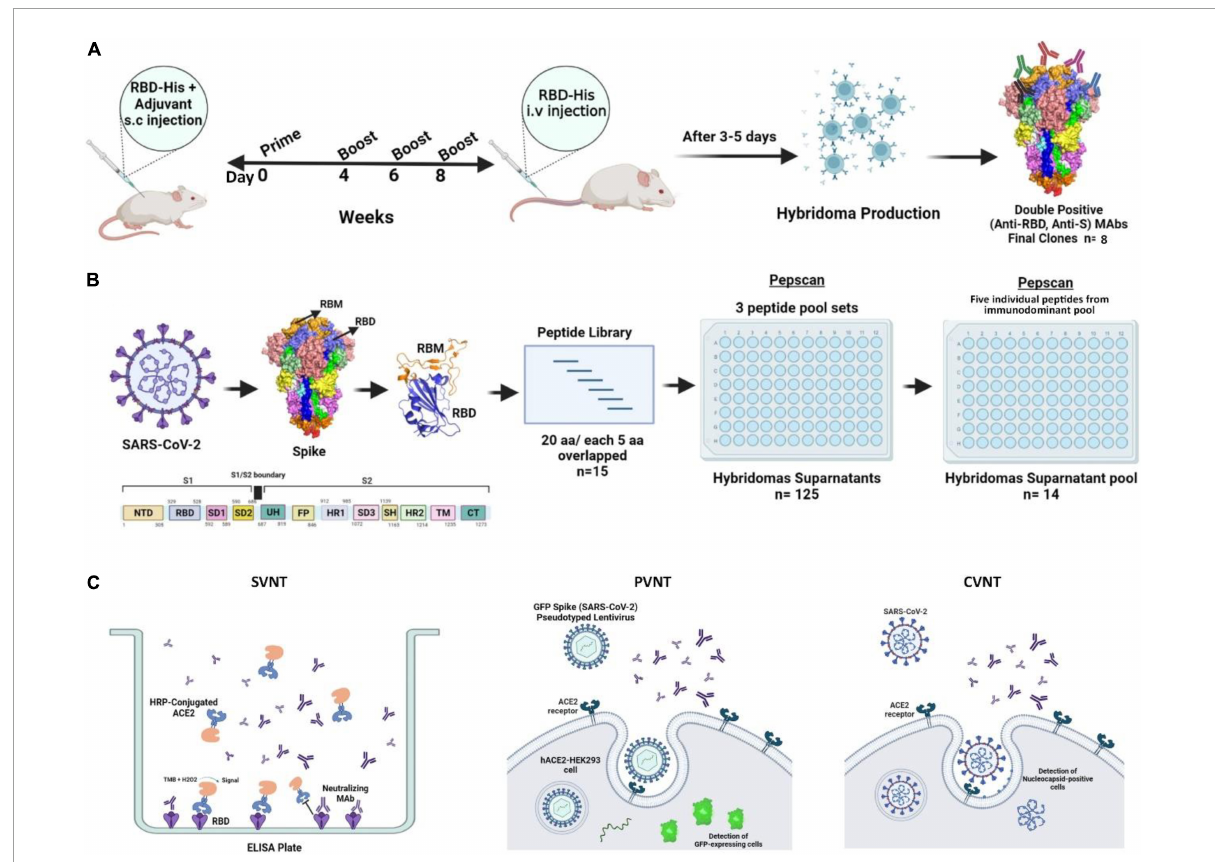
FIGURE1 Schematic representation of mouse immunization and hybridoma production workflow to generate and characterize anti-SARS-CoV-2-RBD MAbs. (A) A total of 6–8-week old female BALB/c mice were immunized with RBD-His and complete Freund’s adjuvant on day 0 followed by boosts with RBD-His and incomplete Freund’s adjuvant at weeks 4, 6, and 8. Blood samples were collected for ELISA before each injection. A total of 3–5 days after intravenous injection of RBD, mice were sacrificed and splenocytes were fused with Sp2/0 cells. Finally, eight clones were generated with reactivity against both RBD and S antigens. (B) SARS-CoV-2 RBD Pepscan was performed using a panel of linear peptides spanning the entire sequence of SARS-CoV-2 RBD of spike containing 20 amino acid residues with 5 residues overlapping with the adjacent peptides for the characterization of hybridoma supernatants and purified MAbs. First, the reactivity of hybridoma supernatants was assessed against three peptide pool sets. Subsequently, the linear peptide-reacting hybridoma supernatants were pooled and their reactivity was assessed against individual peptides of the immunodominant peptide pool. (C) SVNT, PVNT, and CVNT were performed to characterize MAbs. aa, amino acid; ACE2, angiotensin-converting enzyme-2; CVNT, conventional virus-neutralizing test; ELISA, enzyme-linked immunosorbent assay; HRP, horse-radish peroxidase; i.v., intravenous; MAb, monoclonal antibody; PVNT, pseudovirus neutralizing test; RBD, receptor binding domain; RBM, receptor binding motif; S, spike; SARS-CoV-2, severe acute respiratory syndrome coronavirus 2; s.c., subcutaneous; SVNT, surrogate virus-neutralizing